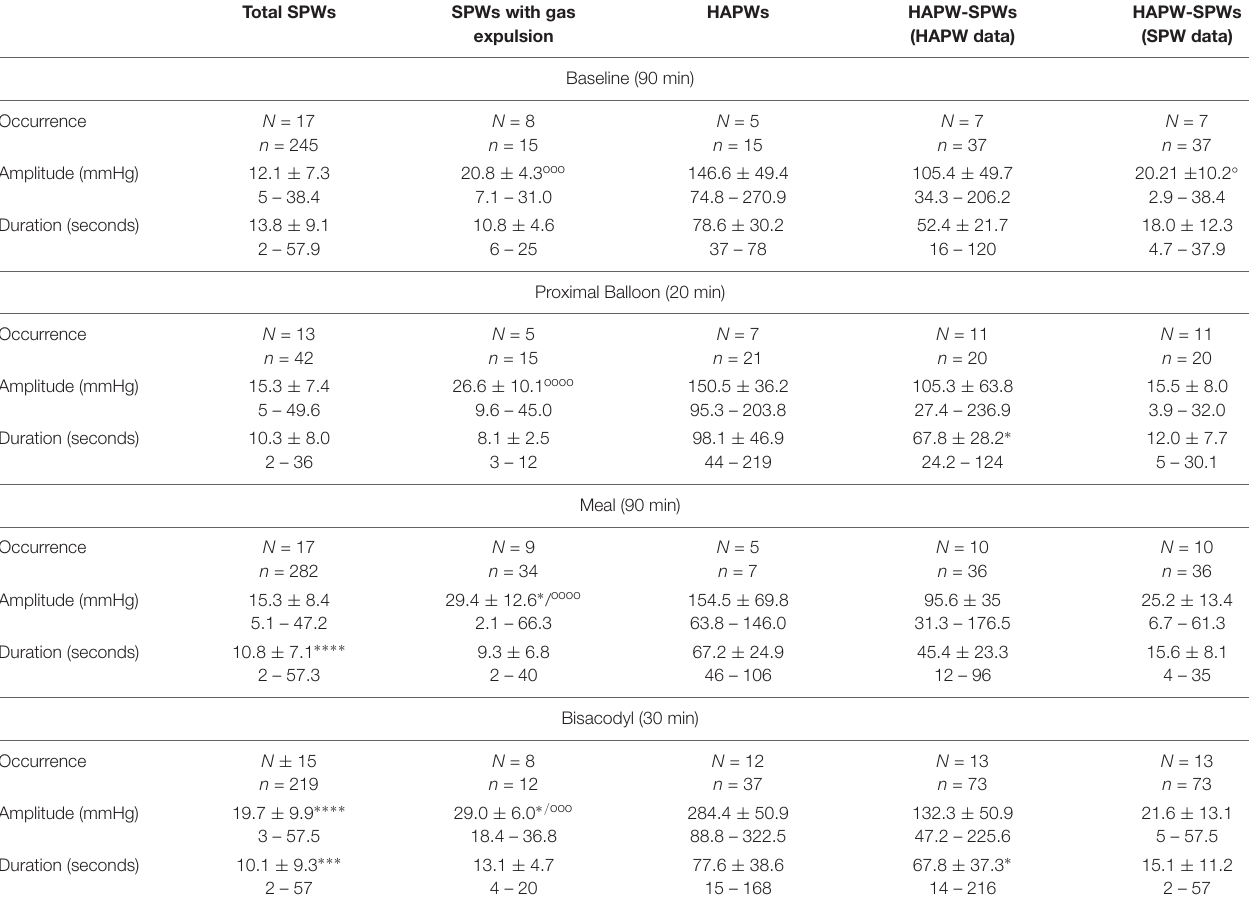
TABLE 1 | Quantification of SPW activity in 17 healthy subjects.